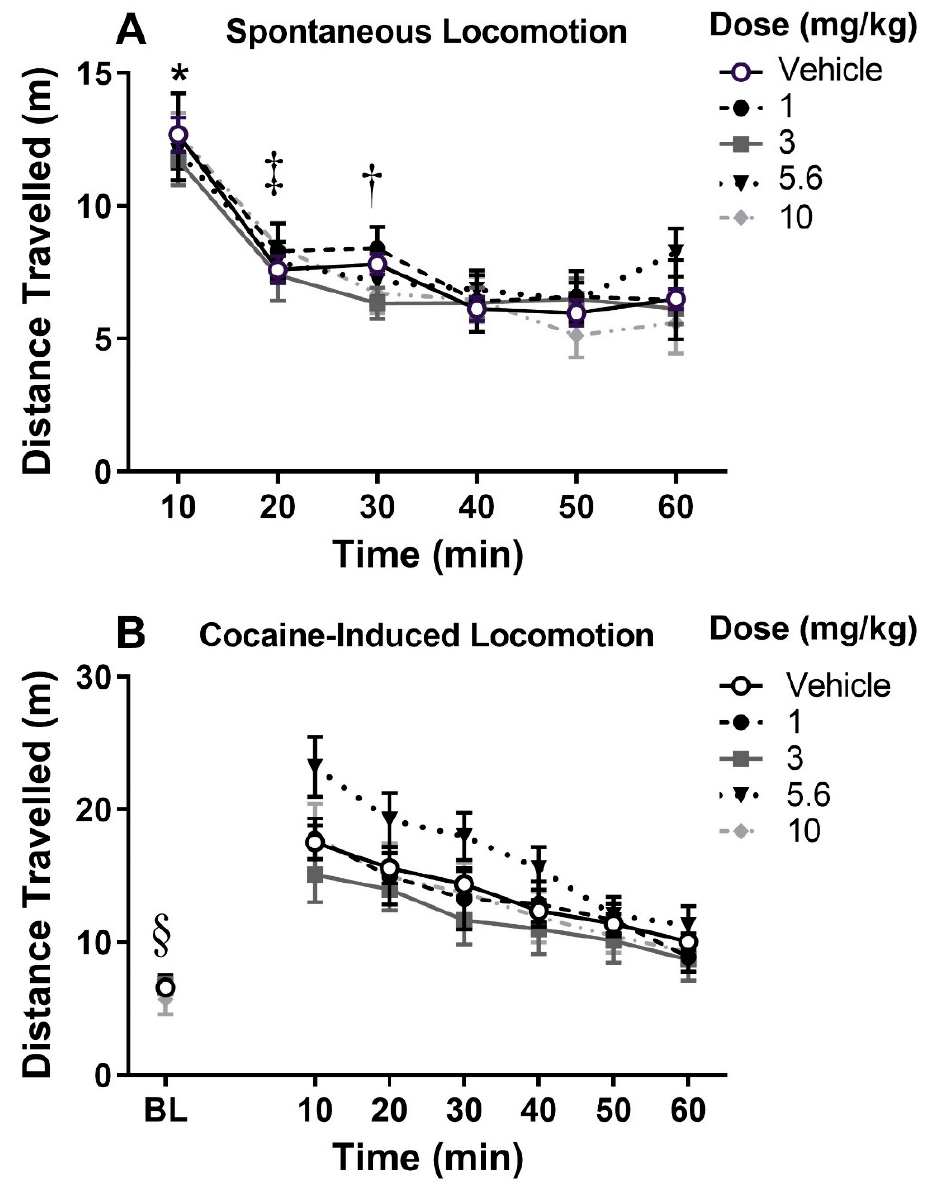
Figure 2. Spontaneous ( A ) and cocaine-induced locomotion ( B ) in rats after vehicle or an assigned dose of MC-25-41 (1.0, 3.0, 5.6, or 10 mg / kg, IP; n = 8–12 / dose). Data are the mean ± standard error of the mean (SEM). * indicates di ff erence from all other time bins with post hoc Tukey’s test. ‡ indicates di ff erence from 40, 50, and 60 min time bins with post hoc Tukey’s test. † indicates di ff erence from 40, 50 time bins with post hoc Tukey’s test. § indicates baseline di ff erence from all other time points with post hoc Dunnett’s test.